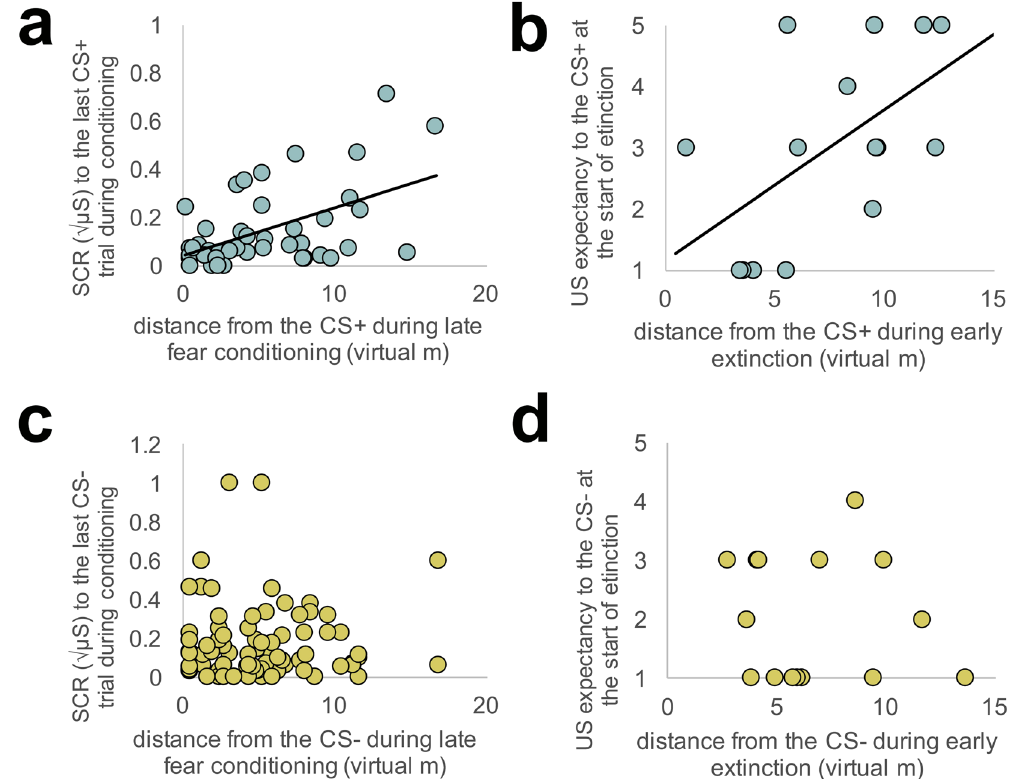
Figure 5. Inter-relations among subjective, physiological, and behavioral measures of conditioned fear. ( a ) Children who kept more distance from the CS + during fear conditioning showed higher skin conductance response (SCR) to the last CS + trial during conditioning, suggesting that avoidant behavior may predict higher physiological fear responding. ( b ) Children who reported higher US expectancy to the CS + subsequently kept more distance from the CS + during extinction. This suggest that CS − US contingency awareness may relate to avoidant behavior. ( c , d ) These associations were not significant for the CS − . CS + and CS- refer to the avatar (virtual person) that was paired or unapired with the US (white noise burst), respectively, during fear conditioning. Abbreviations: CS, conditioned stimulus; US, unconditioned